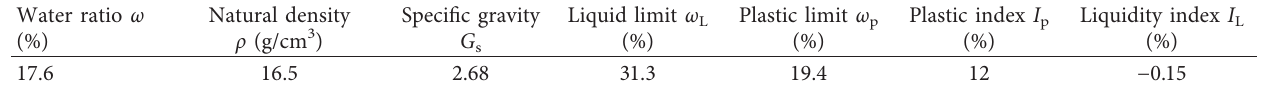
Table 1: Physical property index of the natural undisturbed loess samples.